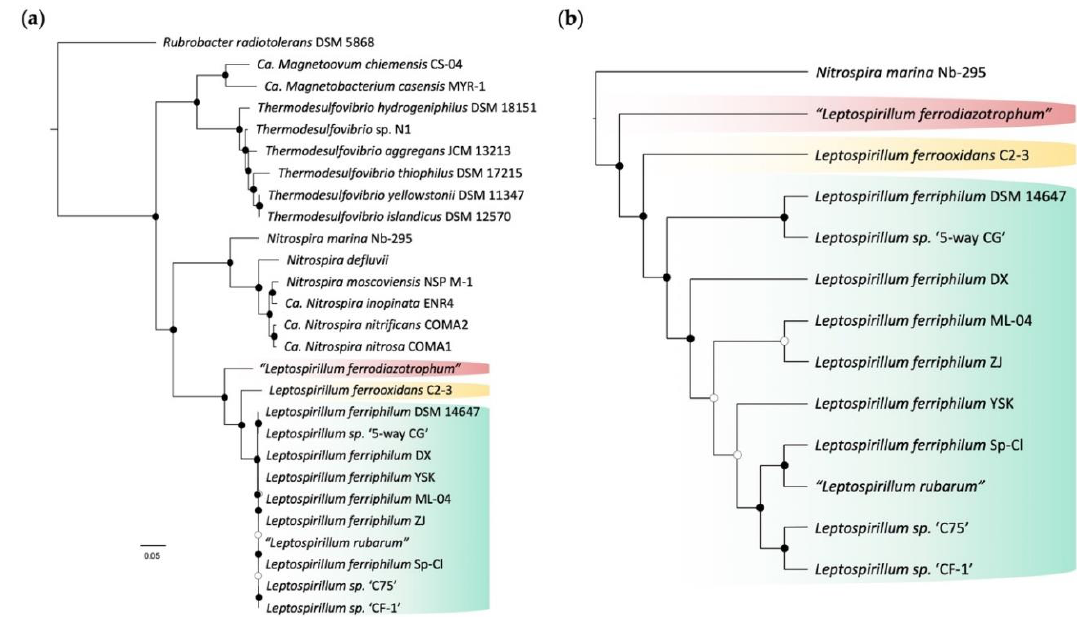
Figure 2. 16S rRNA phylogeny and cladogram of Leptospirillum species with sequenced genomes used in this study. Clades belonging to Leptospirillum Groups I (yellow), II (green), and III (red) are indicated. ( a ) Phylogeny of the Leptospirillum genus inferred from 16S rRNA gene sequences. Filled circles at the nodes indicate bootstrap support ≥ 60% and open circles bootstrap support < 60%. The scale bar indicates the number of nucleotide substitutions per site. ( b ) Cladogram of the Leptospirillum genus derived from the 16S rRNA gene phylogenetic tree using N. marina as an outgroup. The cladogram shows the predicted branching order of the Leptospirillum genus. Bootstrap values are derived from Figure 2a. Color coding is the same as shown in Figure 2a.